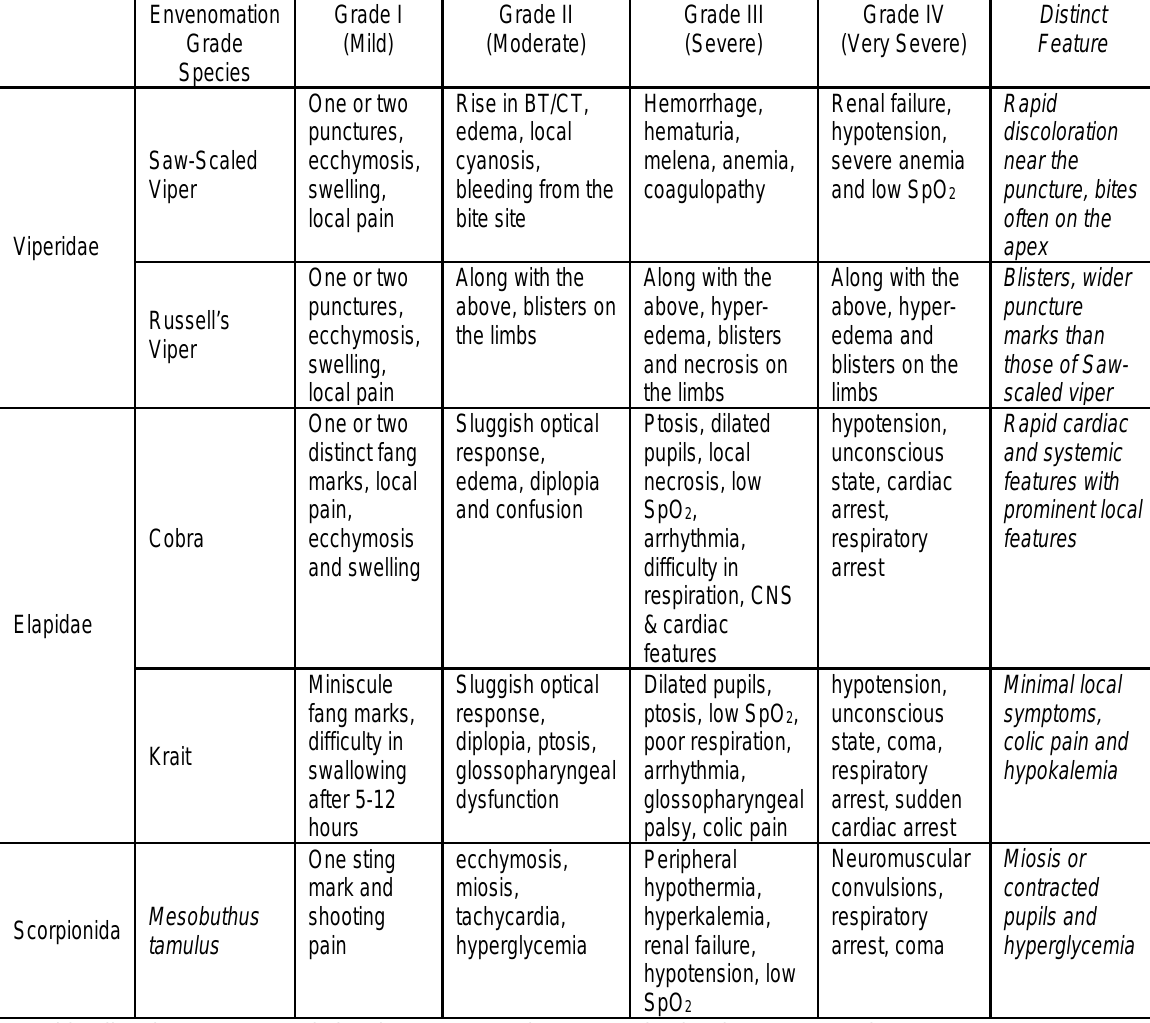
Table 1: Symptomatic identification of venomous snakes in